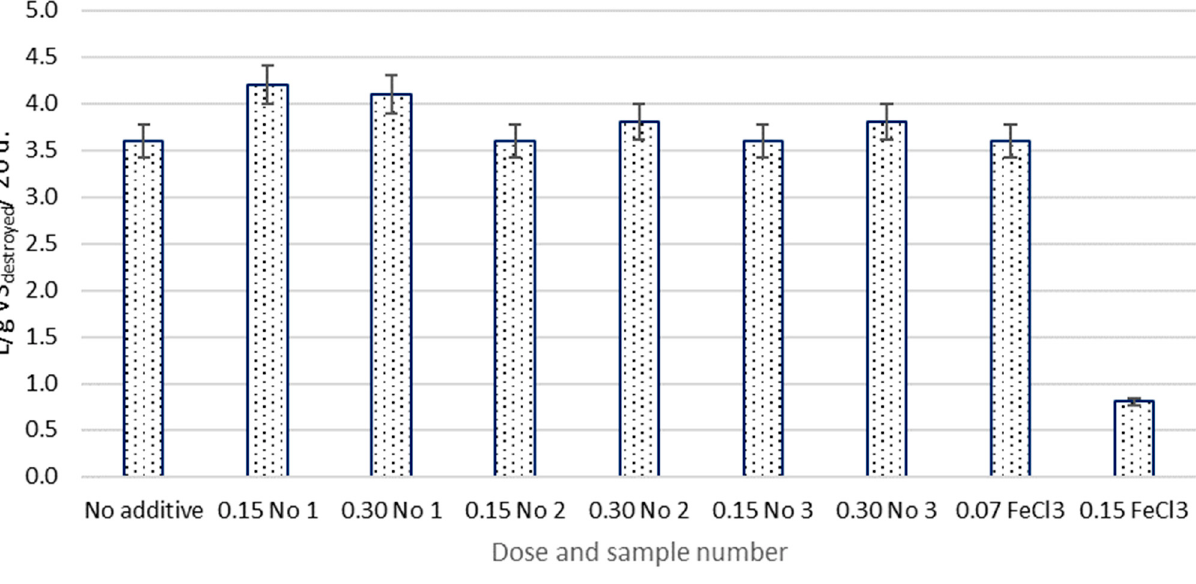
Figure 5. Speci fi c biogas production. Doses of the additives are indicated in g/g SM/20 d.